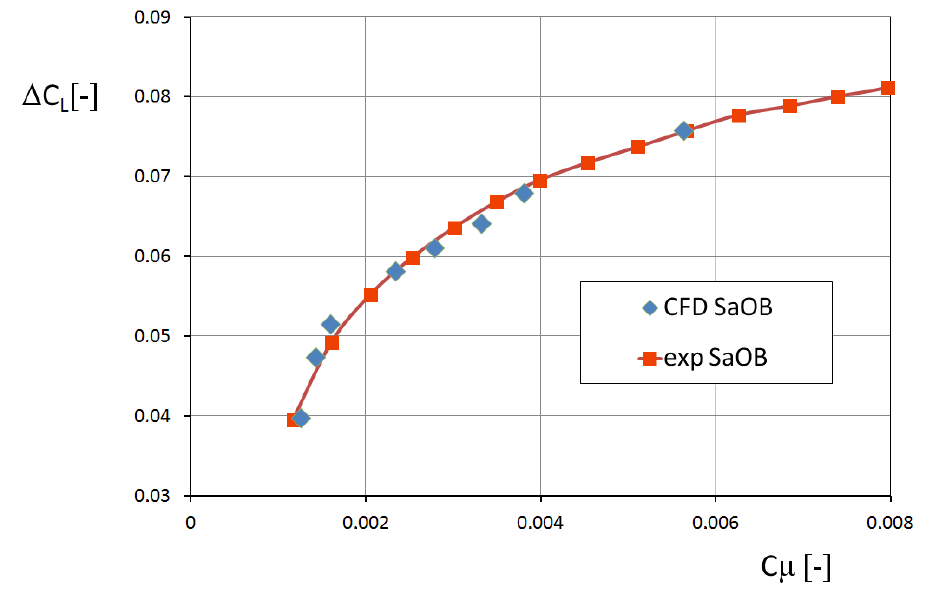
Figure 14. Comparison of the experimental data (taken from [21]) with the CFD results. Steady suction and oscillatory blowing actuator active.